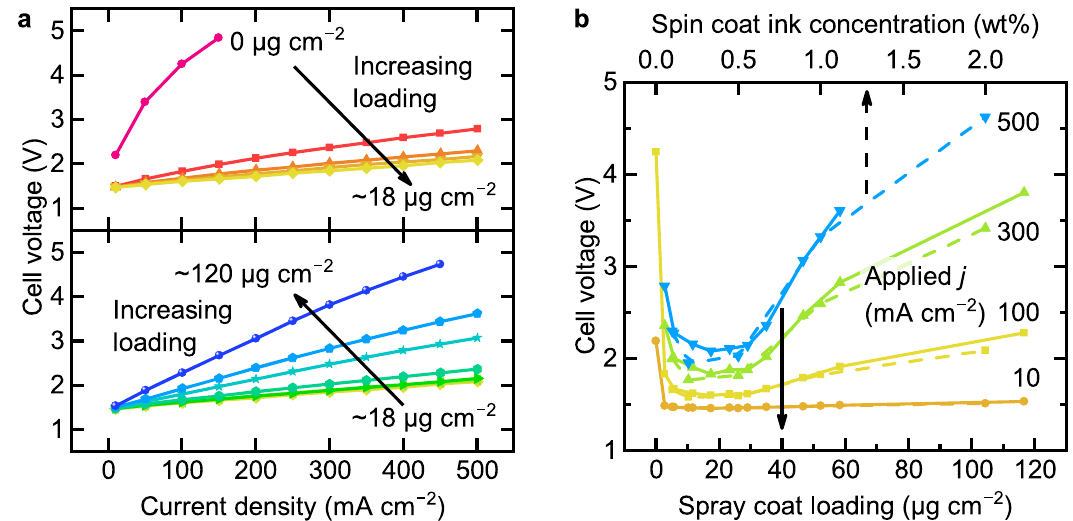
Fig. 2 Performance of BPM electrolyzers with TiO2-P25 as WD catalysts. a Polarization curves of BPM electrolyzers with different loadings of TiO 2 -P25 WD catalyst deposited by spray coating. b Cell voltage of BPM electrolyzers as a function of spray-coating loading (solid lines) of TiO 2 -P25 and spin- coating ink concentration (dashed lines) of TiO 2 -P25 at different applied current densities. The 2.0 wt% sample is 1.0 wt% ink spun twice. The temperature is 55 ± 2 °C (maximum fl